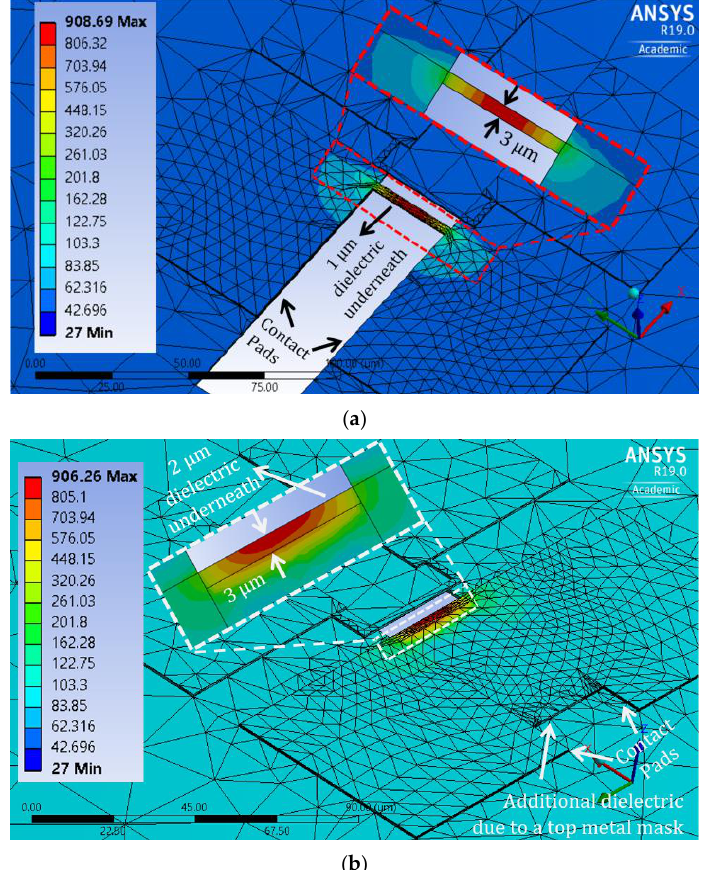
Figure 4. Thermal–electric simulation results of poly-1 partially suspended microheater (PSM) designs: ( a ) design-1 and ( b ) design-2.